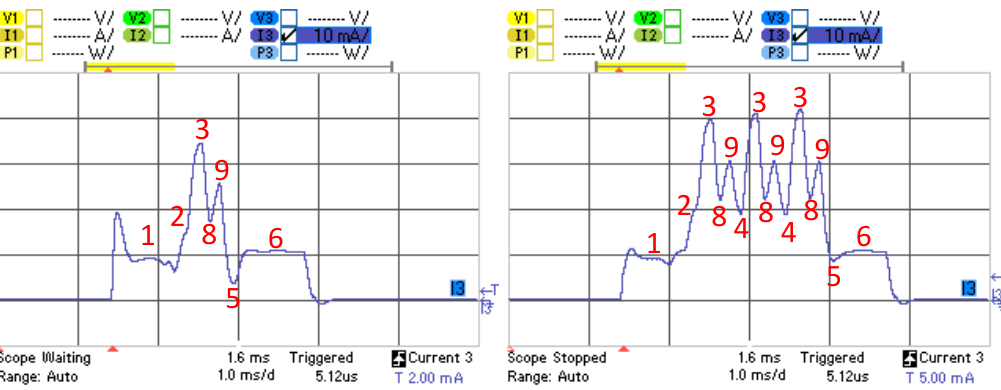
Figure 6. Current consumption profile of an advertising event for the BLE121LR platform, operating as a connectable advertiser. Single-advertisement ( Left ) and three-advertisement ( Right ) advertising events are shown. Table 2. Definition of additional states and relevant variables for the advertiser in the connection-based approach. As the advertisement packet size is different from the one in the advertisement-based approach, details regarding advertisement transmission in the connection-based approach are provided in the table. In the measurements, the slow clock function offered by the BLE121LR platform was disabled.